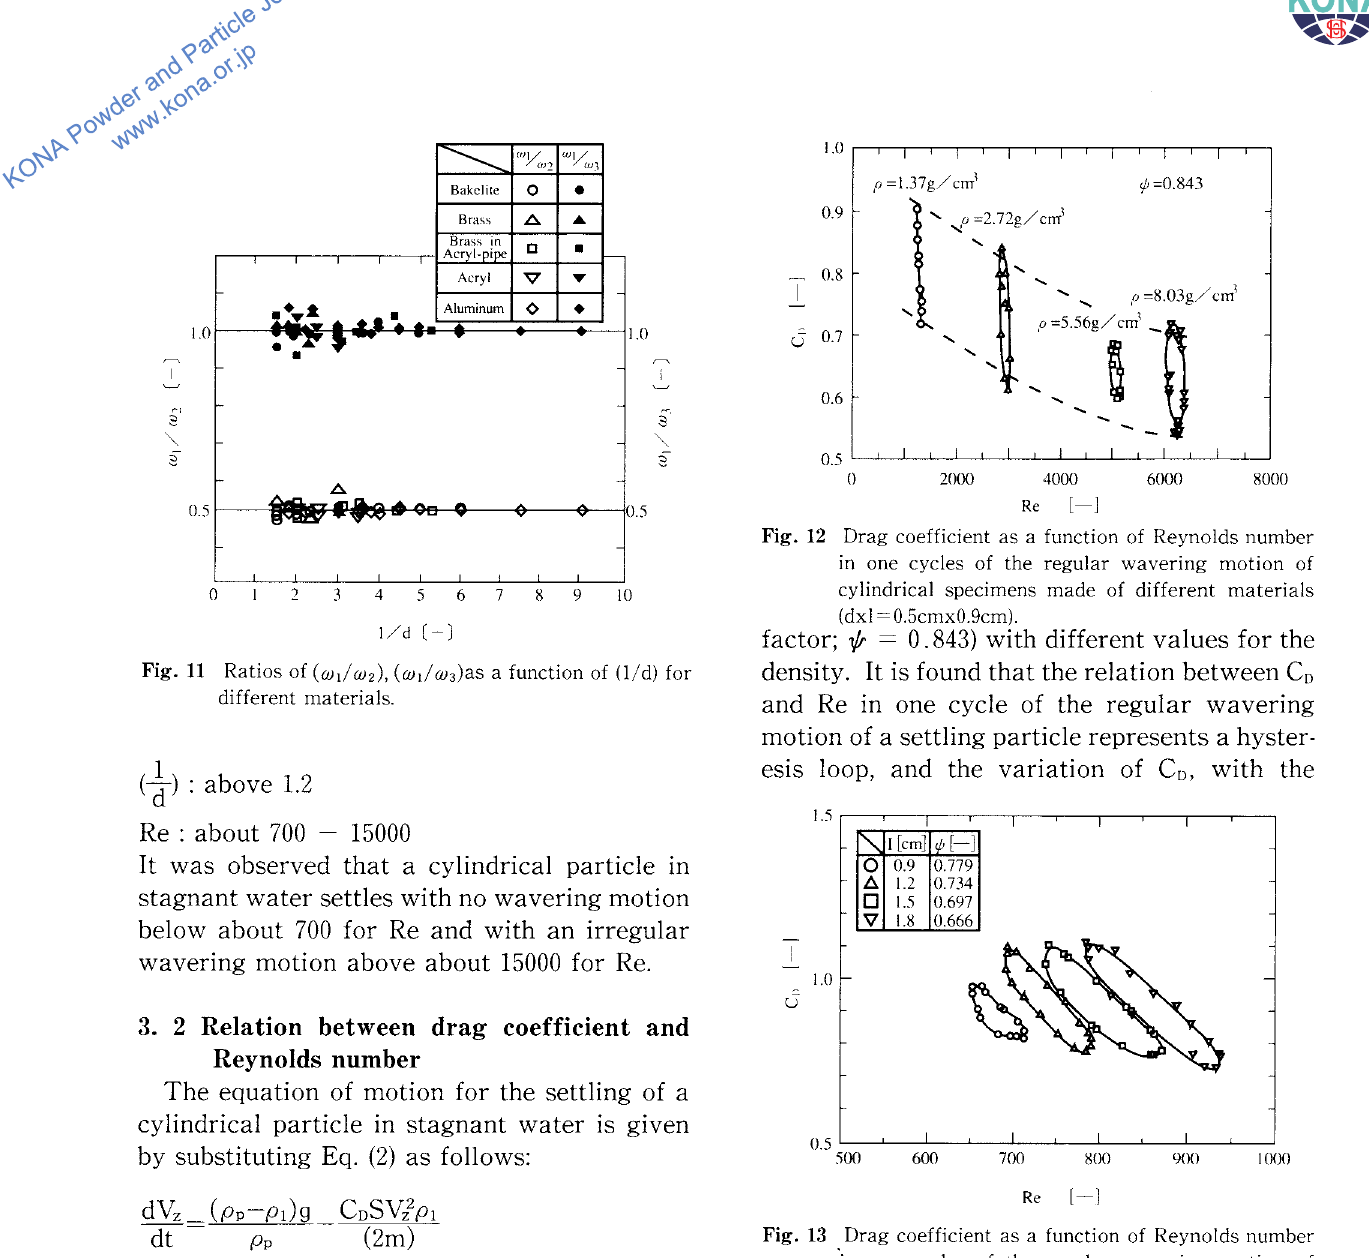
Fig. 13 Drag coefficient as a function of Reynolds number in one cycles of the regular wavering motion of brass specimens with d =